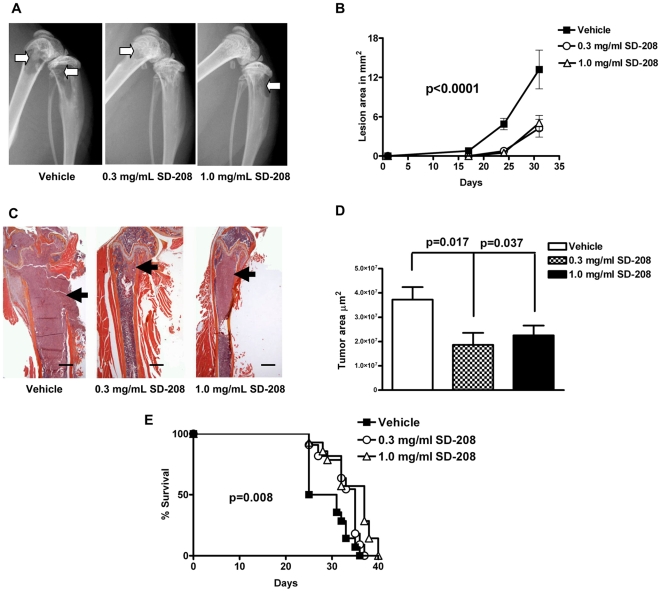
Preventive treatment with SD-208 reduces osteolytic bone lesions and increases survival.(A) Representative x-ray images from hindlimbs of mice inoculated with MDA-MB-231 cells and treated ± SD-208 (0.3 mg/mL or 1.0 mg/mL), arrows indicate osteolytic bone lesions. (B) Osteolytic lesion area measured on radiographs of hindlimbs and forelimbs from mice with bone metastases. Results are expressed as the mean area ± SEM per mouse. **** P<0.0001 0.3 mg/mL and 1.0 mg/mL SD-208 compared to vehicle, using a two-way ANOVA with a Bonferroni post-test at 4 weeks. (C) Representative histology of femurs with tumor indicated by arrows. Scale bar equal to 500 µm. (D) Tumor burden in hindlimbs and humeri was measured by quantitative histomorphometry. Results are expressed as the mean ± SEM area per bone. Statistical analysis by one-way ANOVA with a Newman-Keuls multiple comparison test. (E) Kaplan-Meyer analysis of mouse survival analyzed using a Logrank test.